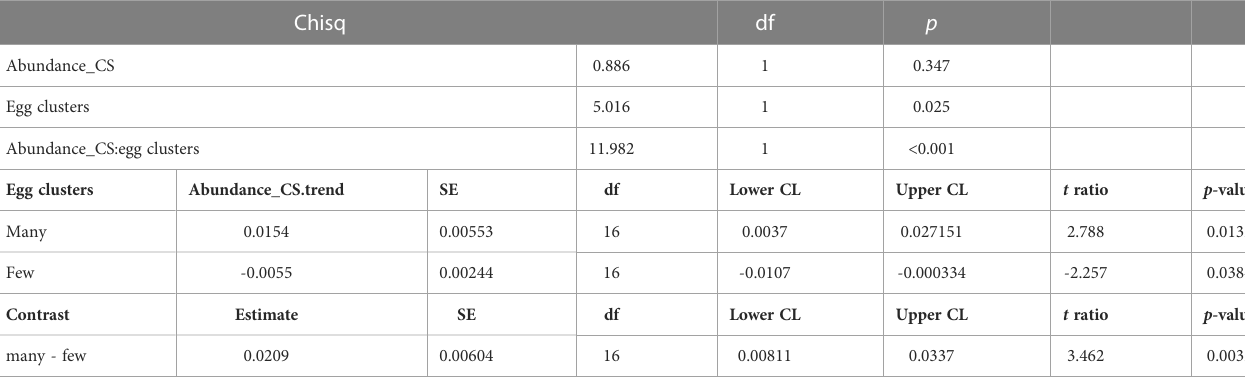
TABLE 2 Upper part: Chisq, degrees of freedom, and p ‐ values for the site model..